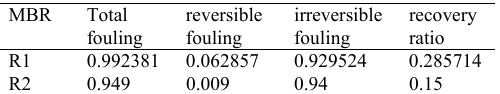
Table 2: membrane fouling measurement Table 2. Membrane fouling